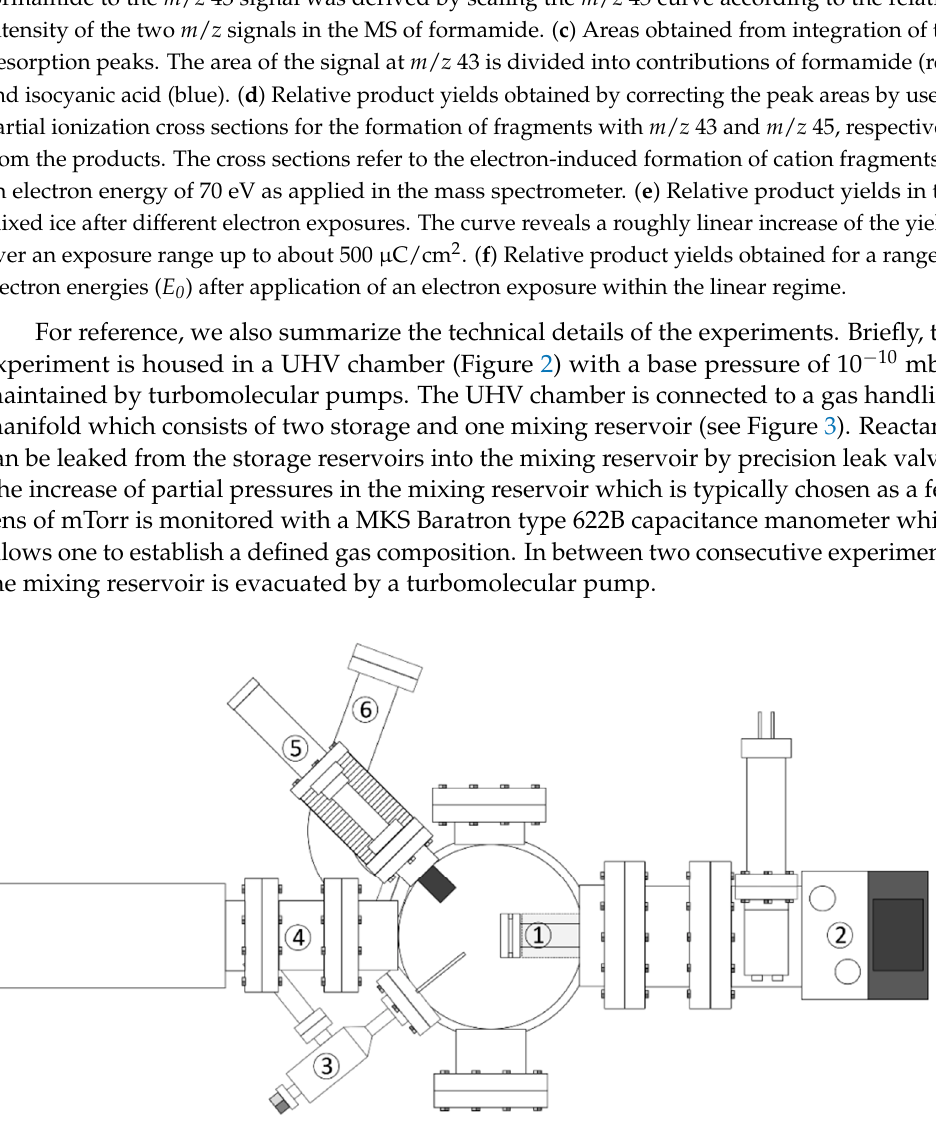
Figure 2. Schematic representation of the UHV chamber: (1) sample holder, (2) closed-cycle helium cryostat, (3) valve to gas handling manifold, (4) residual gas analyzer, (5) electron source, and (6) ion gauge.